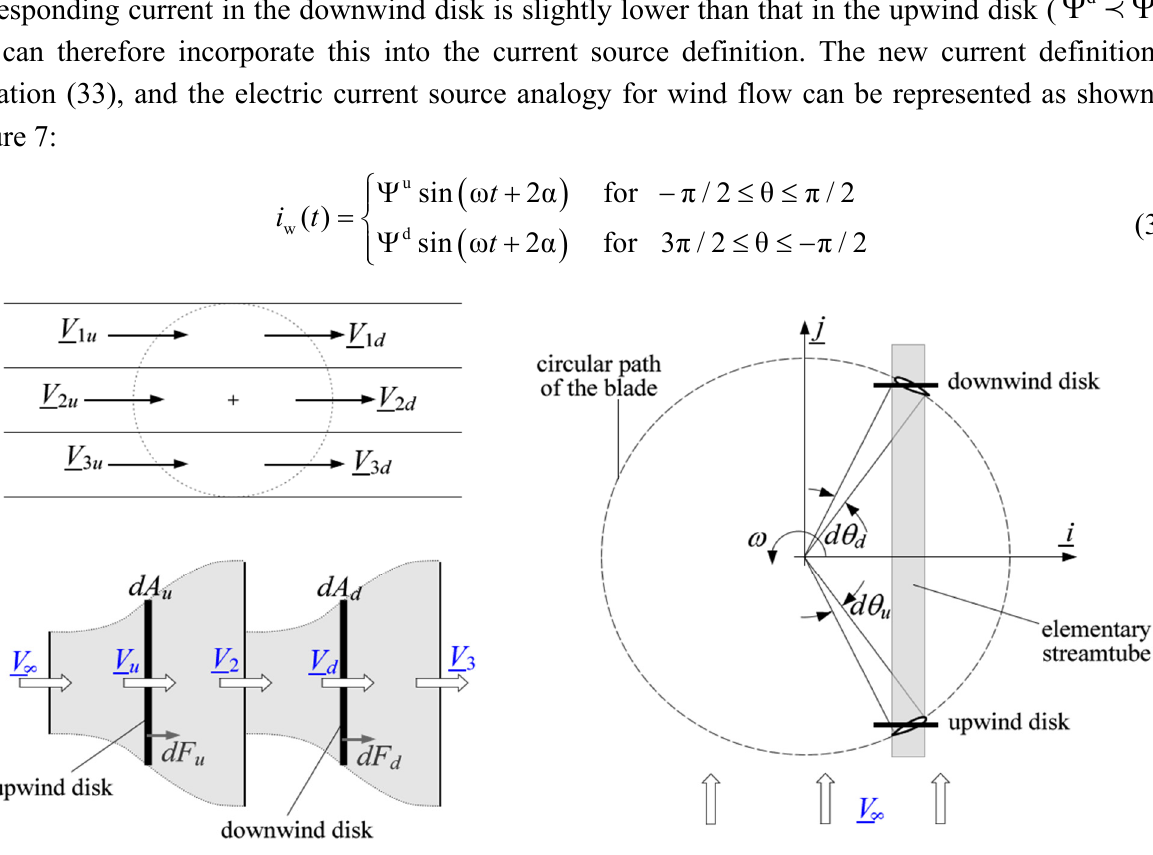
Figure 6. Double-multiple multi-streamtube